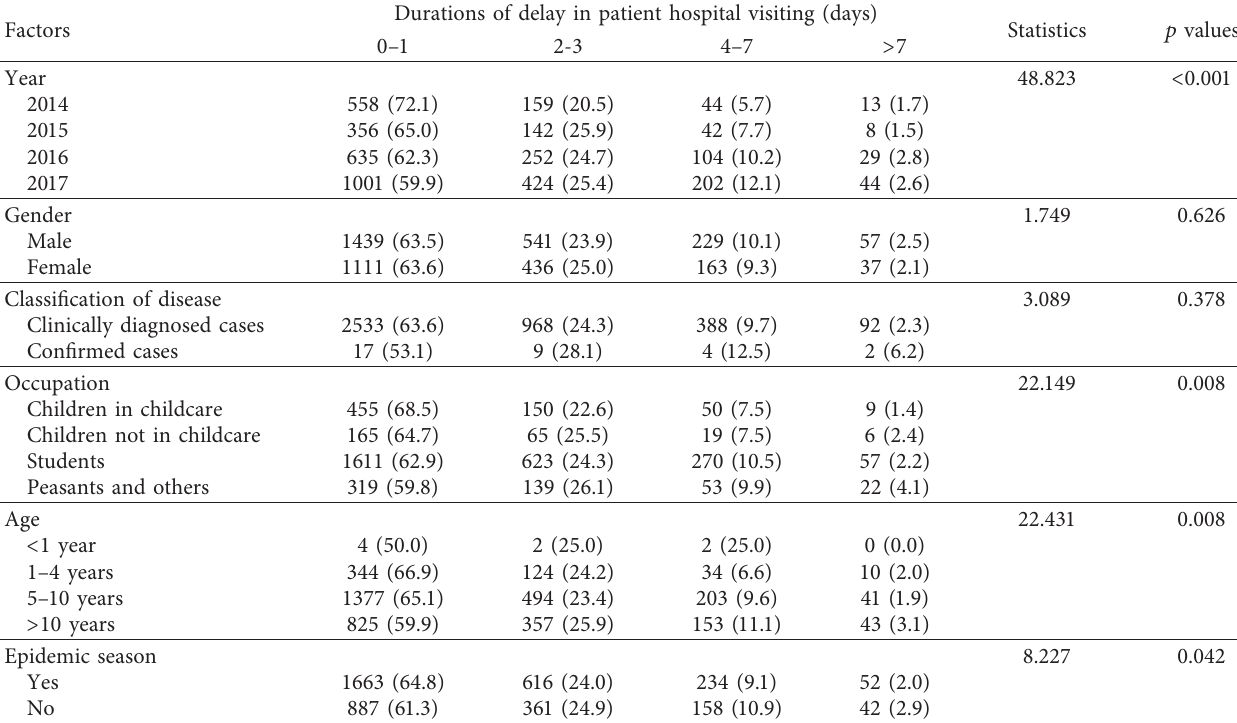
Table 3: Comparisons of durations of delay in patient hospital visiting for epidemic parotitis across different